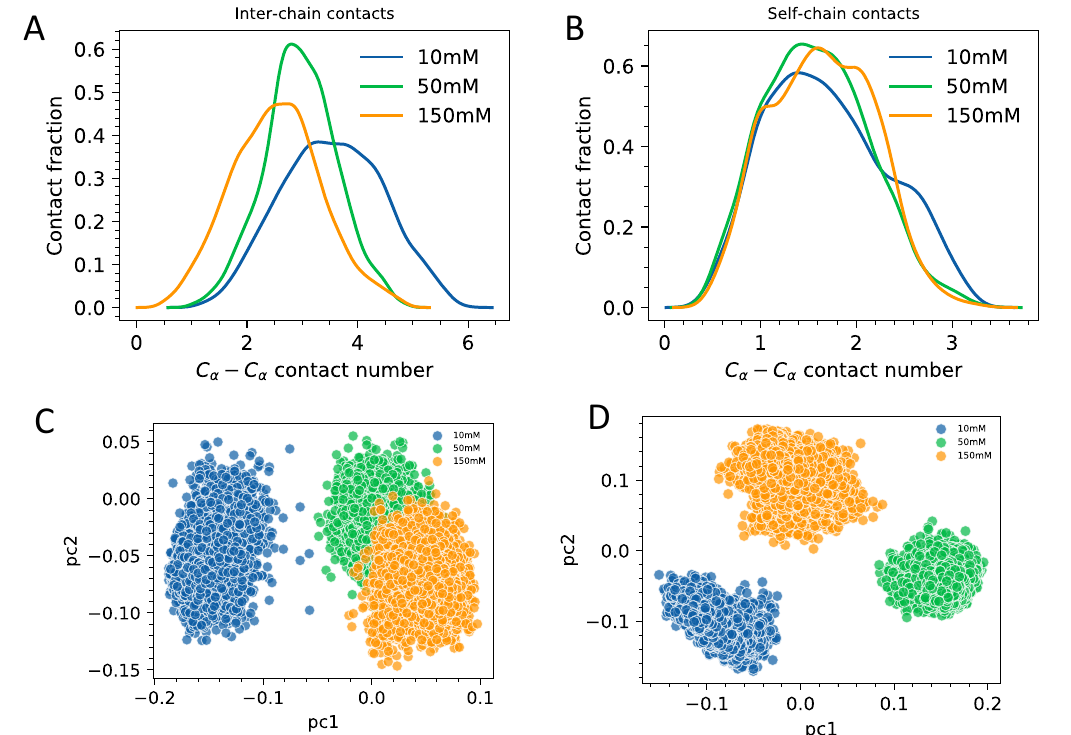
Figure 5. ( A ) The ensemble-averaged inter-chain contact number distribution. ( B ) The ensemble-averaged intra-chain contact number distribution. Contact is defined via r < 0.7 nm switch function for C α − C α pairs beyond 1–3 neighbors. ( C ) Projection of the fuzzy dimeric trajectories onto the first two principal components in the space of backbone dihedral angles. ( D ) Projection of the single-chain trajectories onto the first two principal components in the space of backbone dihedral